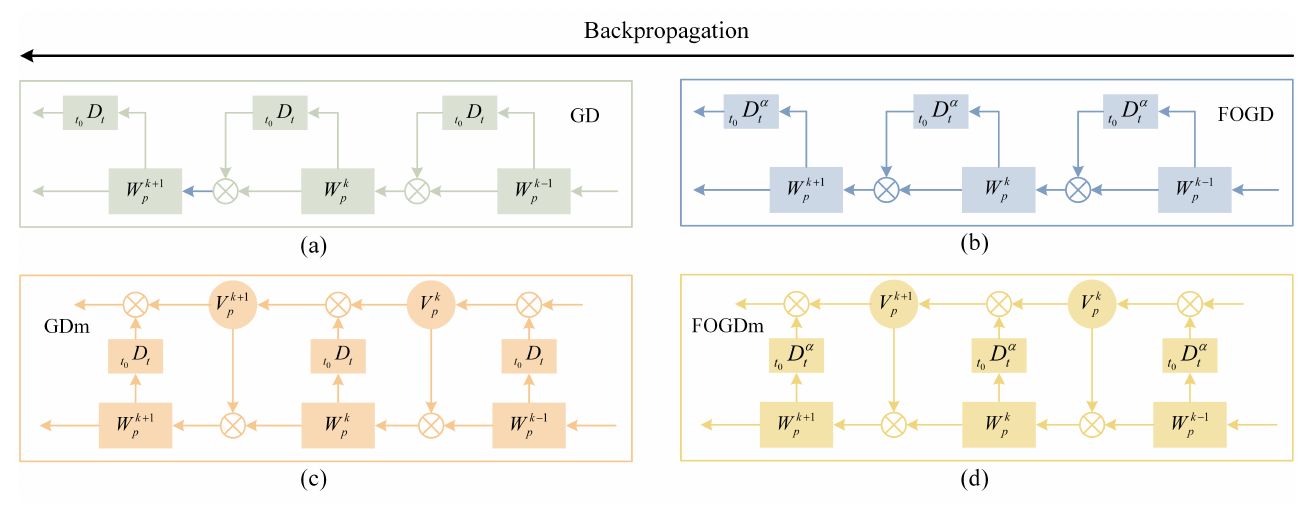
Figure 6. Fractional-order gradient descent methods, ( a ) integer-order GD method, ( b ) fractional- order GD method (FOGD), ( c ) integer-order GD method with momentum (GDm), and ( d ) fractional- order GD method with momentum